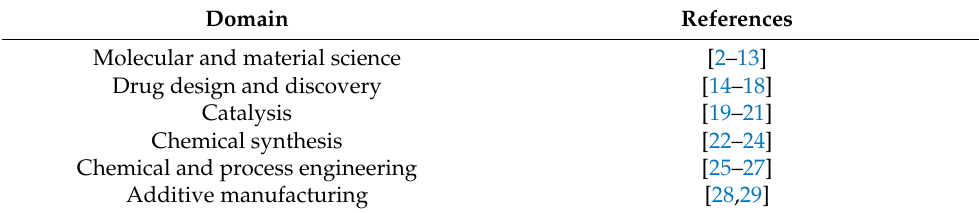
Table 1. ML reviews in different domains of chemistry and chemical